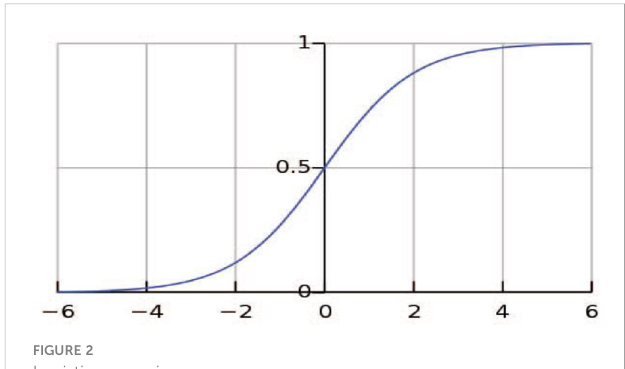
FIGURE 2 Logistic regression